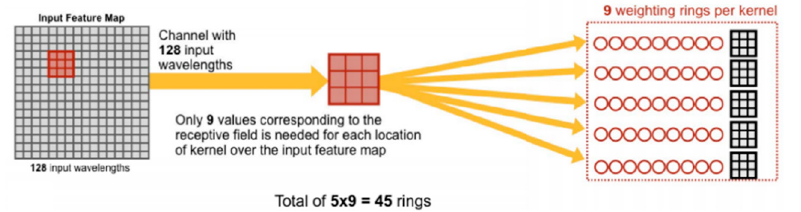
Figure 5. MRR structure is for an input feature map of size 16 × 16. After filtering the map with input feature mapping, the convolution is completed [33].